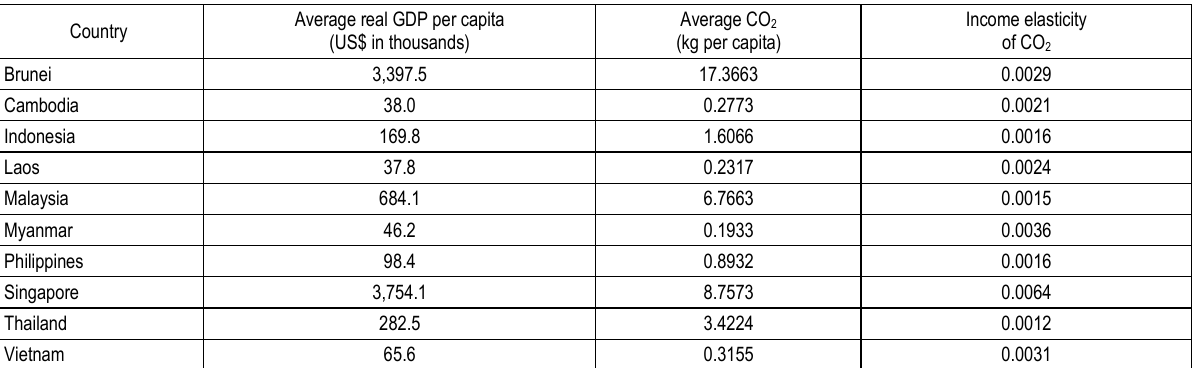
emissions for individual countries in SEA 2